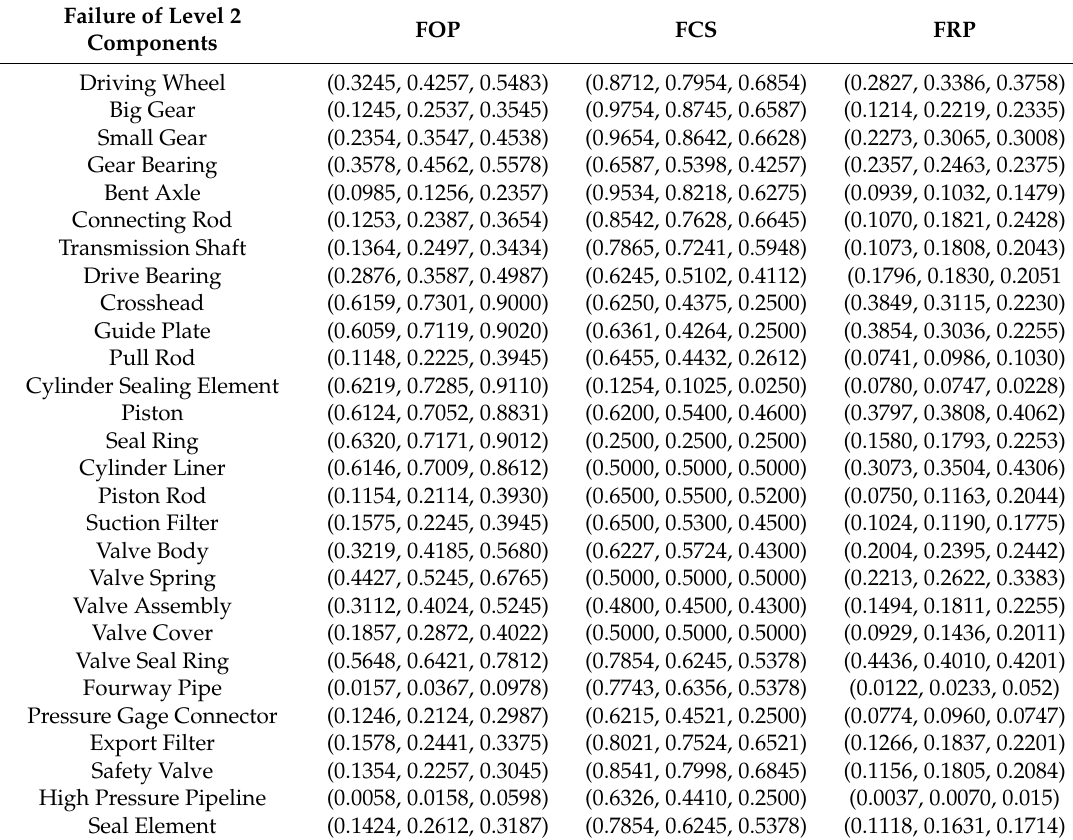
Table 2. The fuzzy occurrence probability (FOP), fuzzy consequence severity (FCS), and fuzzy risk priority (FRP) of the components in the reciprocating pump system